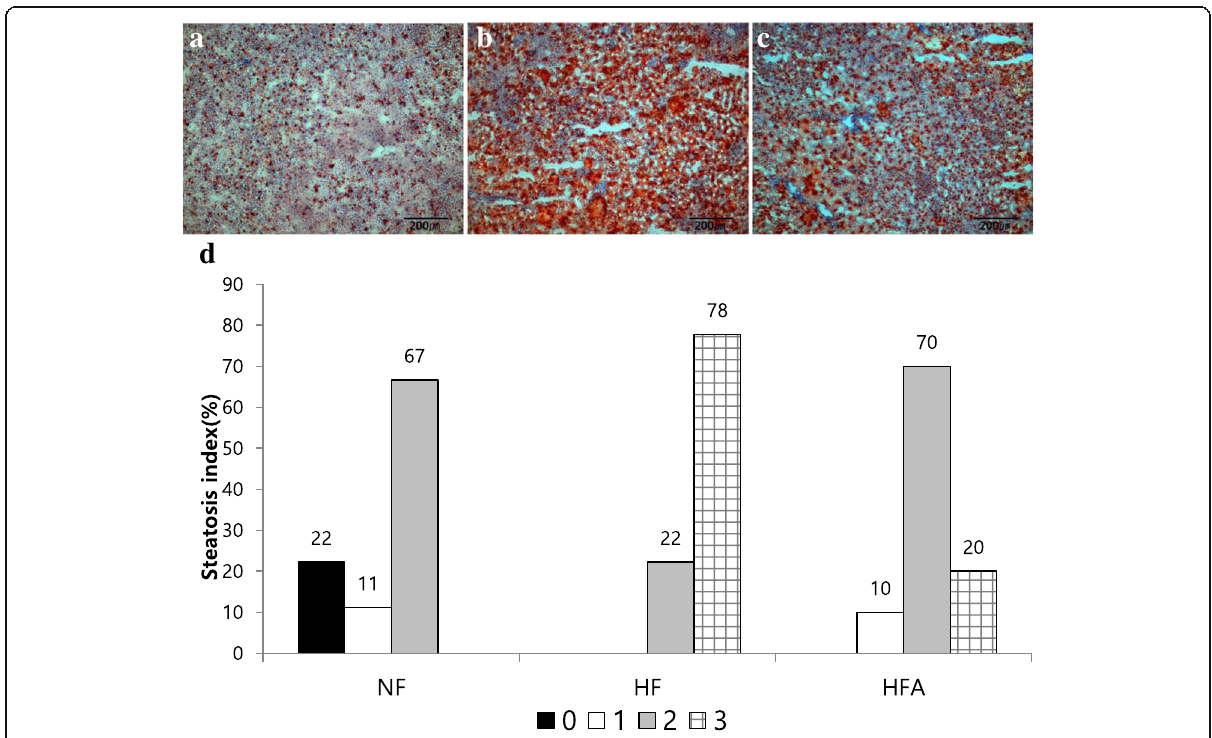
Fig. 2 Effect of A. pilosa on hepatic steatosis in rats fed a high-fat diet. Photomicrographs of Oil red O-stained liver samples from representative animals in the NF ( a ), HF ( b ), and HFA ( c ) groups (× 400). ( d ) Percentage of hepatic steatosis grade (0 – 3 scale) within each group ( n = 9 – 10). Data are expressed as percentage within group. Hepatic steatosis was graded as 0 (fatty hepatocytes occupying < 5%), 1 (fatty hepatocytes occupying 5 – 33%), 2 (fatty hepatocytes occupying 34 – 66%), or 3 (fatty hepatocytes occupying > 66%) Abbreviations: NF, normal-fat diet; HF, high-fat diet; HFA, high-fat diet with 0.1% Agrimonia pilosa aqueous